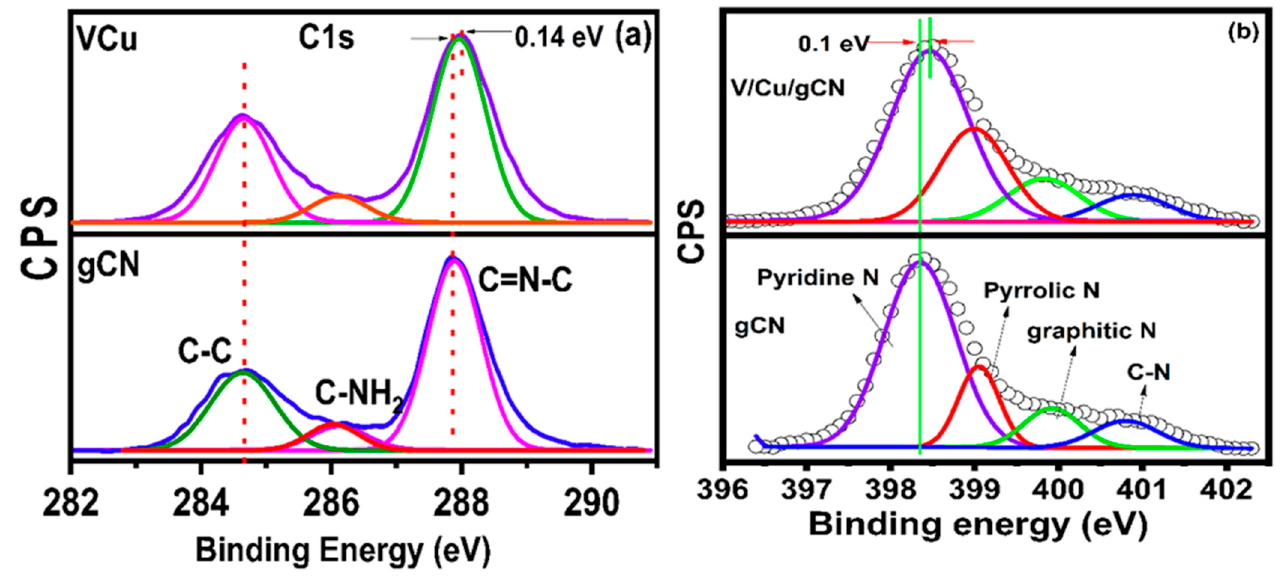
Figure 6. XPS spectra of nanosheets: ( a ) C1s spectra of gCN and V/Cu/gCN nanosheets and ( b ) N1s spectra of gCN and V/Cu/gCN nanosheets .